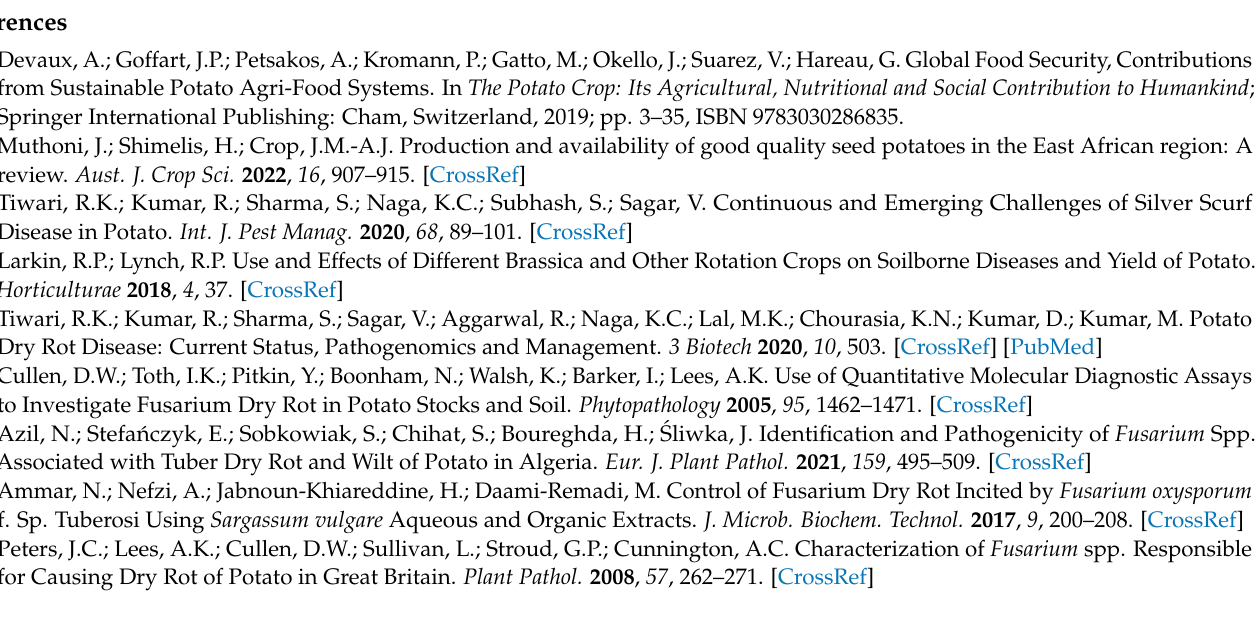
Table S7: Tukey multiple comparison test for glycemic index of Kufri Jyoti and Kufri Frysona when infected with control (water agar), Fusarium sambucinum, Fusarium solani, and Fusarium sambucinum + Fusarium solani and incubated for 0 d, 20 d, 40 d, and 60